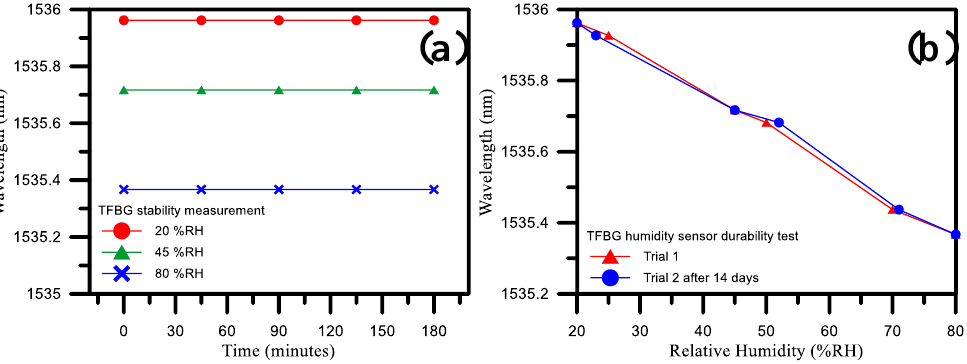
Figure 12. TFBG sensor stability and durability test results for ( a ) 20% RH, 45% RH, and 80% RH measurements, ( b ) trial 1 and trial 2 (conducted 14 days after trial 1).